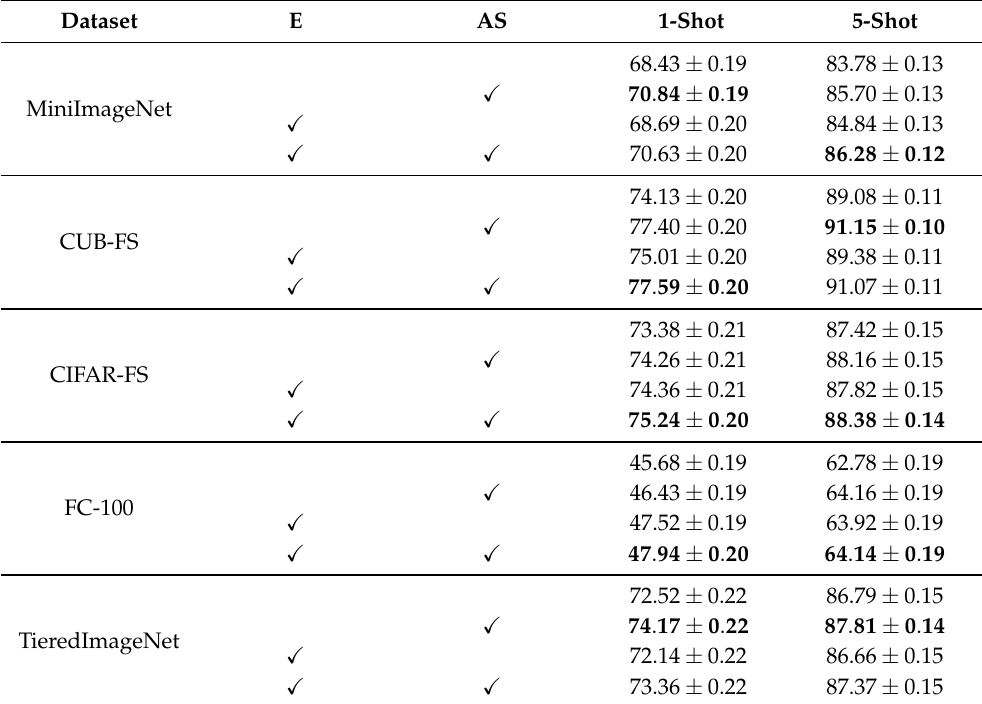
Table 11. Ablation study of the steps of proposed solution in inductive setting, for a fixed number of trainable parameters in the considered backbones. When using ensembles, we use 2 × ResNet12 instead of a single ResNet12.